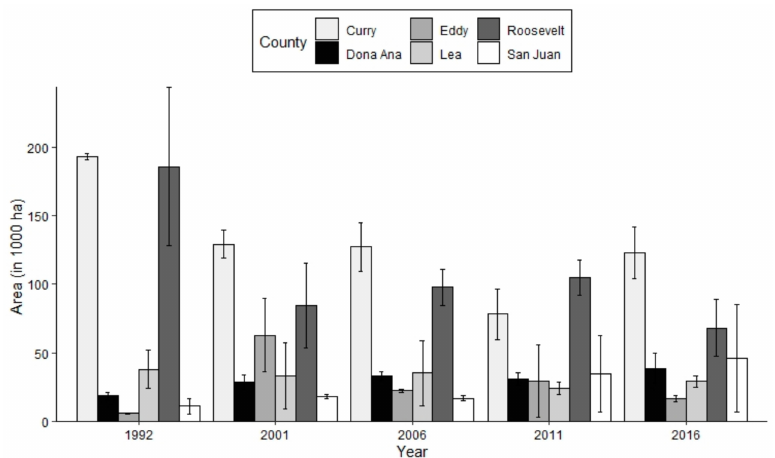
Figure 5. Area estimates of cultivated cropland in the study counties from 1992 to